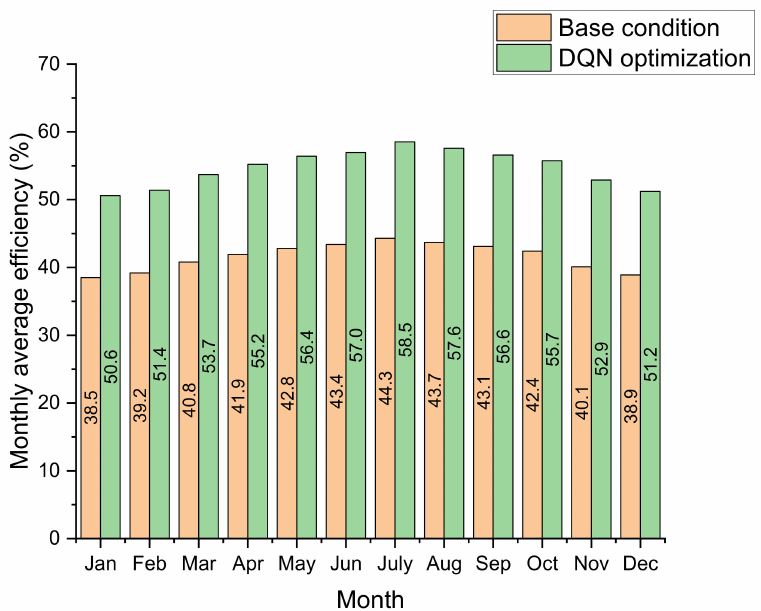
Figure 10. The freshwater production of the solar still with nanofluids optimized by DQN and the solar still with